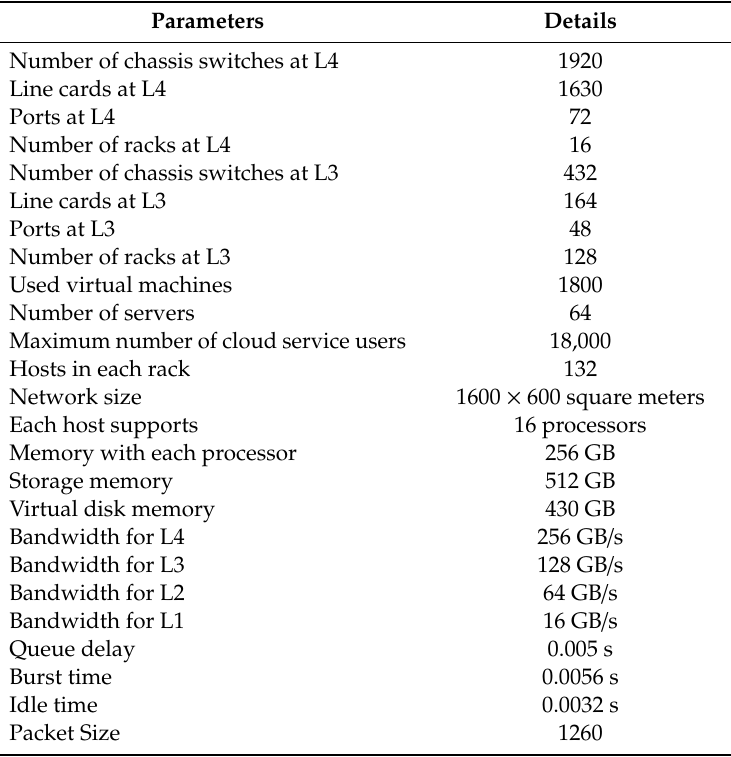
Table 2. Simulation